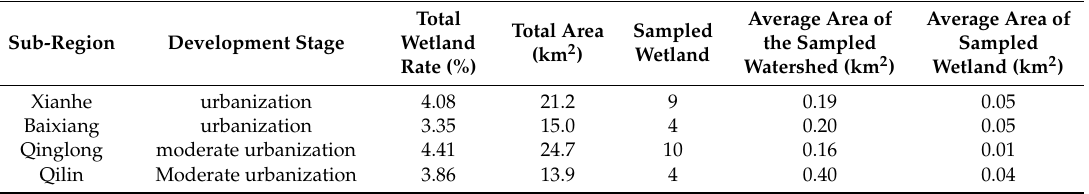
Table 3. Area of total wetlands and selected sampling points in the four sub-regions.